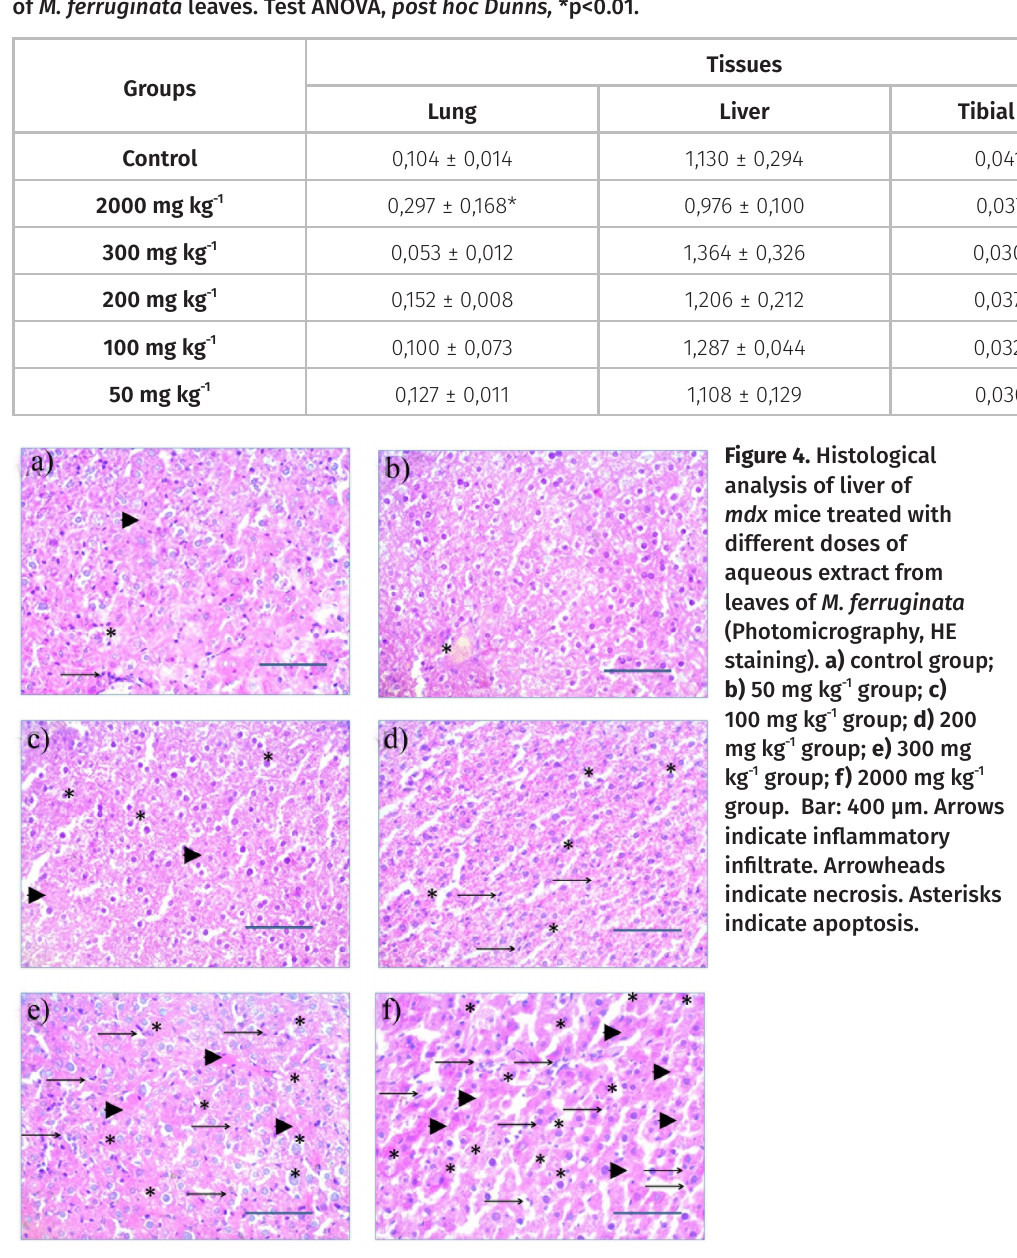
Table I. Mean and standard deviation of organ weight of animals treated with different doses of aqueous extract